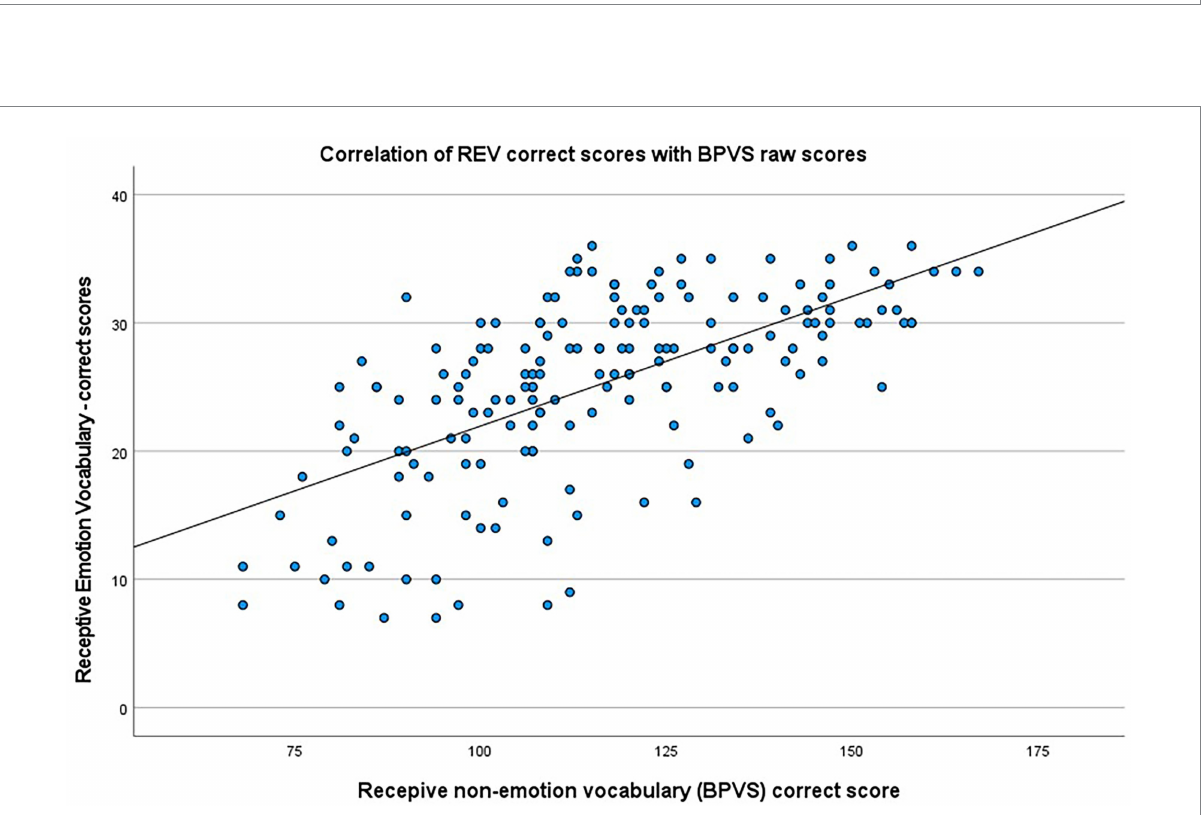
FIGURE 7 Scatterplot showing the correlation between REV scores and BPVS.